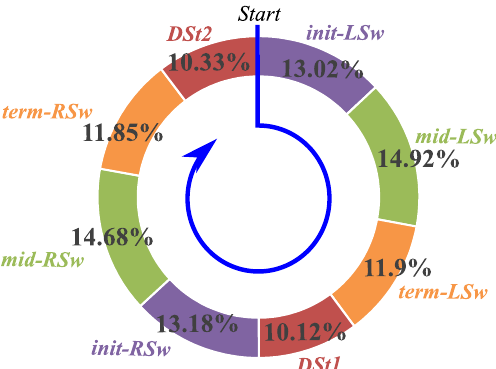
Figure 7. The average percentages of eight gait phases, which are the statistical results of EGC classified by the new gait phase classification method.